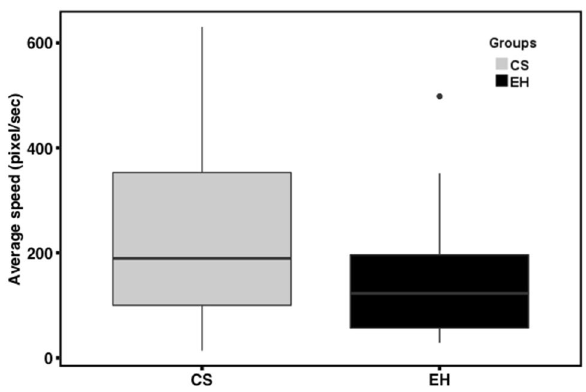
Figure 2. Comparison of average movement speed between groups. The solid line indicates the median. The bottom of the box represents the first quartile (25th percentile) and the top of the box represents the third quartile (75th percentile). Whiskers represent the lower and upper bound for data excluding outliers.